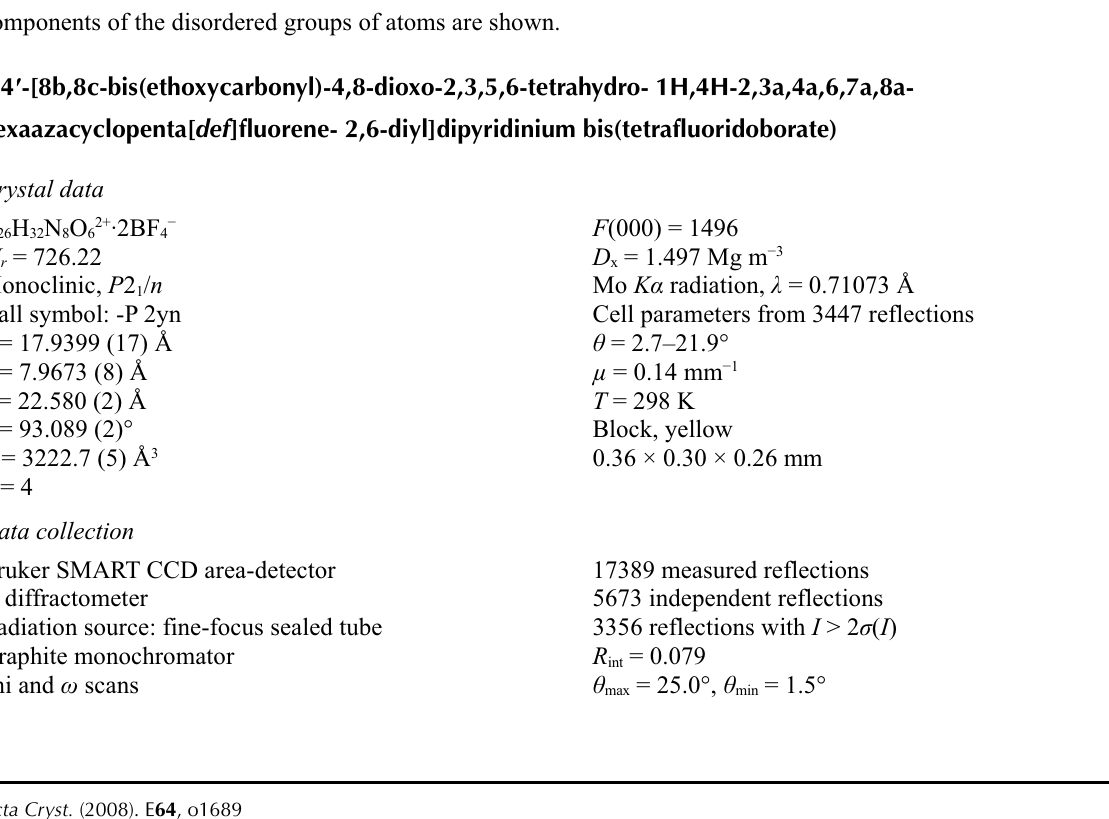
The molecular structure of (I) with 50% probability displacement ellipsoids (arbitrary spheres for H atoms). Only major components of the disordered groups of atoms are